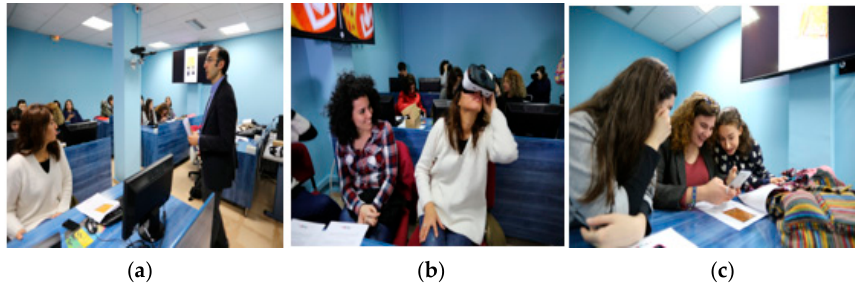
Figure 5. Screenshots of the work process ( a – c ). Source: developed by the authors.